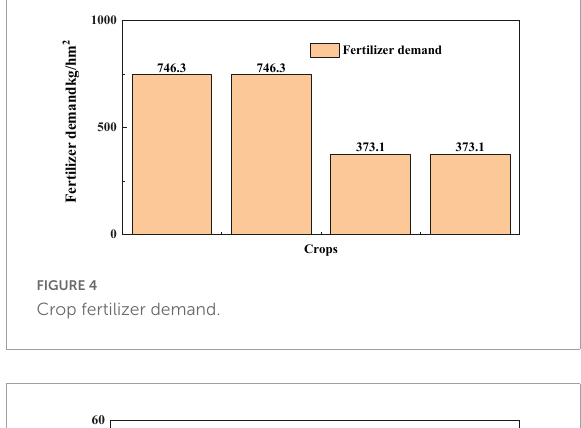
FIGURE3 Crop water demand.